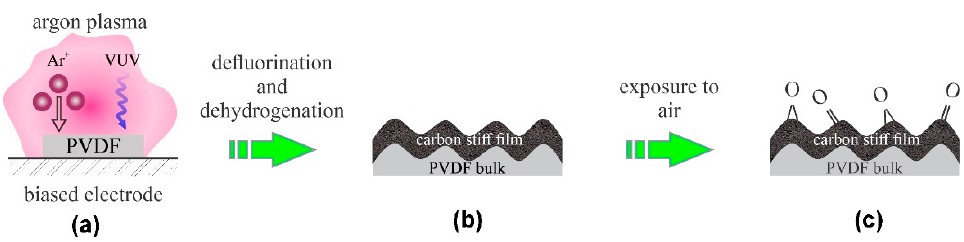
Figure 1. Mechanisms involved in surface modification of PVDF upon exposure to argon plasma sustained by low-pressure capacitively coupled RF discharge: ( a ) polymer is exposed to energetic ions and strong VUV radiation, ( b ) formation of a stiff surface film, and ( c ) oxidation upon exposure to ambient conditions.